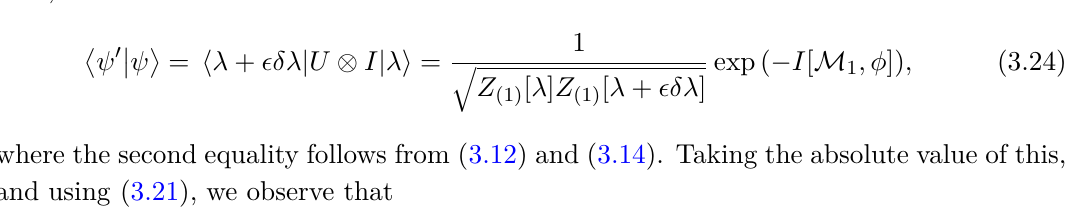
Figure 10. At small (cid:15) , computing the fidelity of ρ R and ρ 0 value of the inner product of two states | λ i and | λ 0 i , with the insertion of a unitary operator U acting at N . We have N ∪ I ∪ R = Σ , where Σ was shown in figure